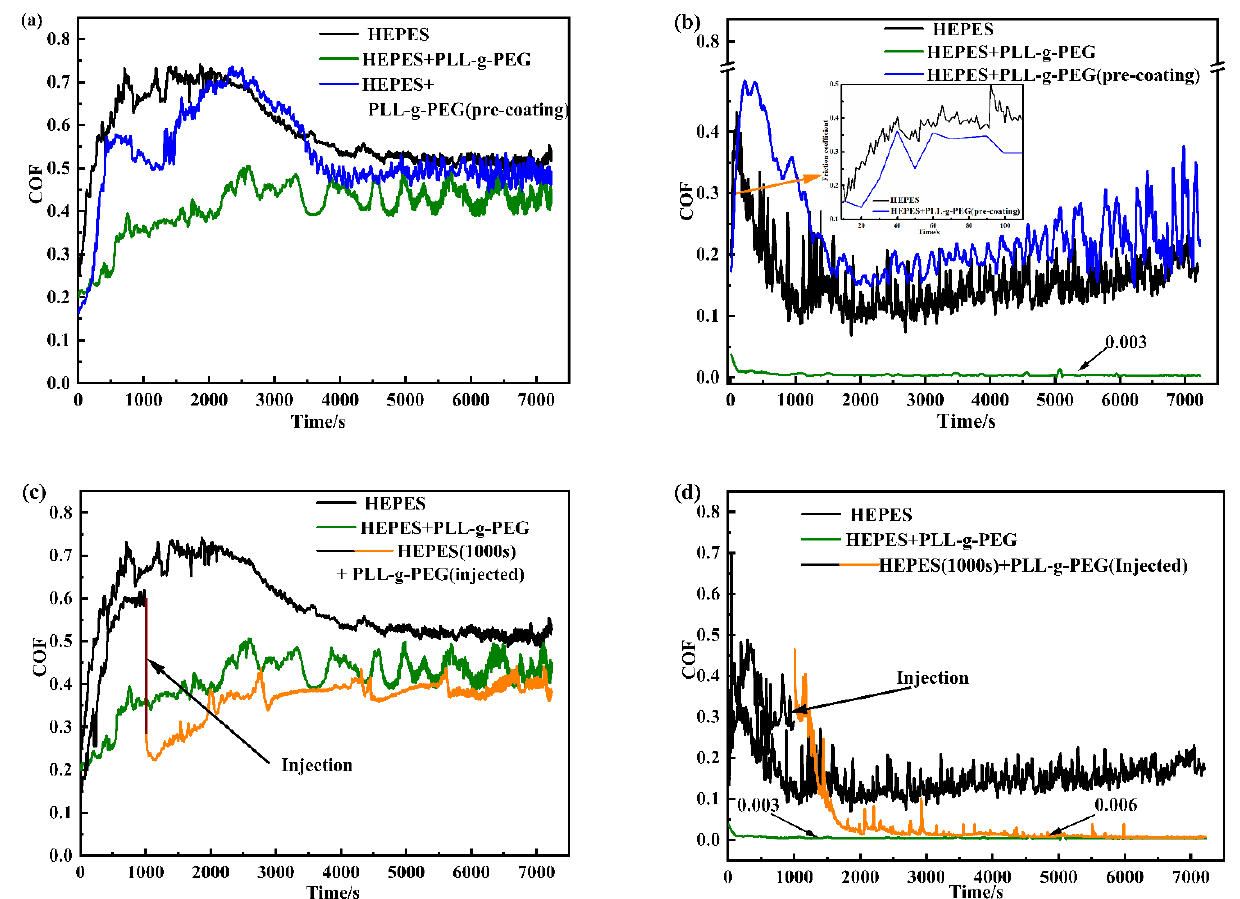
Figure 5. Curves of friction coefficients with time at 10 mm/s and 300 mm/s: ( a ) U e = 10 mm/s; ( b ) U e = 300 mm/s; ( c ) U e = 10 mm/s; and ( d ) U e = 300 mm/s. ( b ) U e = 300 mm/s; ( c ) U e = 10 mm/s; and ( d ) U e = 300